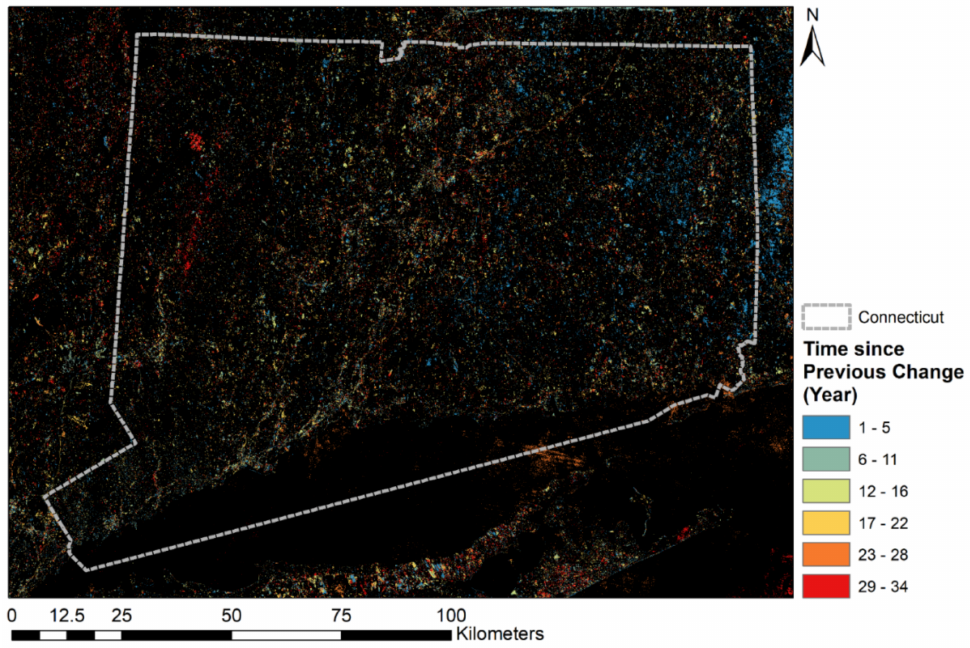
Figure 5. Time since previous change map (30 m) of Connecticut generated from the Continuous Change Detection and Classification (CCDC) algorithm. This product includes land cover type change and condition change. The condition change, such as vegetation regrowth and insect infestation, usually does not change the land cover